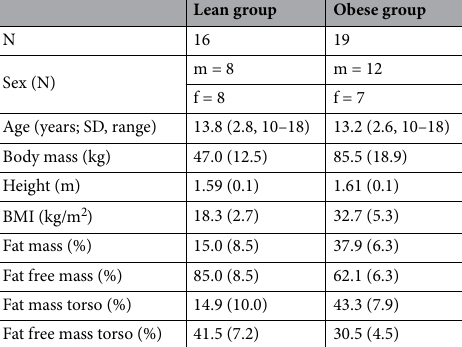
Lean group Obese